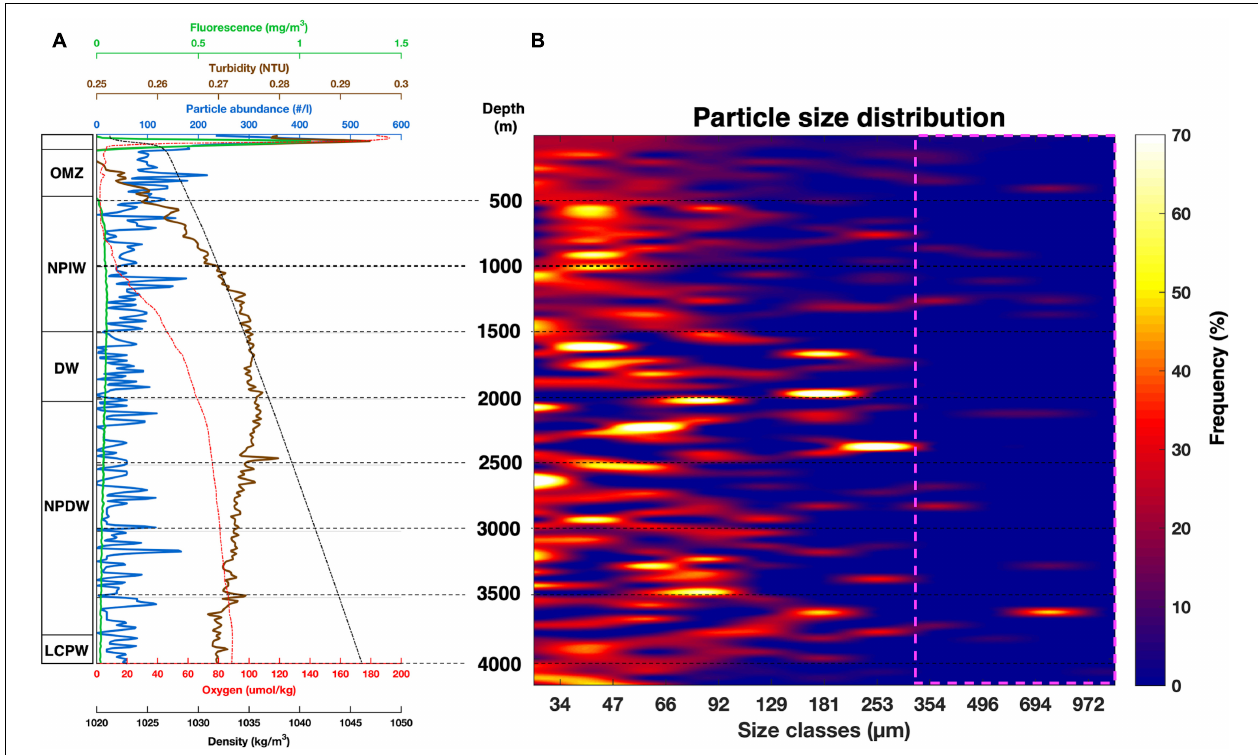
FIGURE 8 | Particle abundance, size distribution and oceanographic parameters from station 2.2. (A) Vertical cross section from CTD data (fluorescence, turbidity, oxygen, density) and particle abundance vs. depth. (B) Particle size-distribution expressed in percent frequency vs. depth. Pink square: statistically low particle count